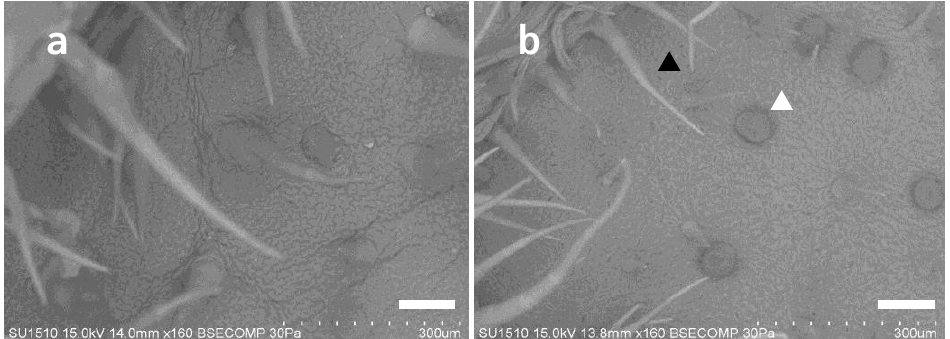
Figure 2. Low-vacuum scanning electron microscope (LVSEM) images of hairy (black triangle) and